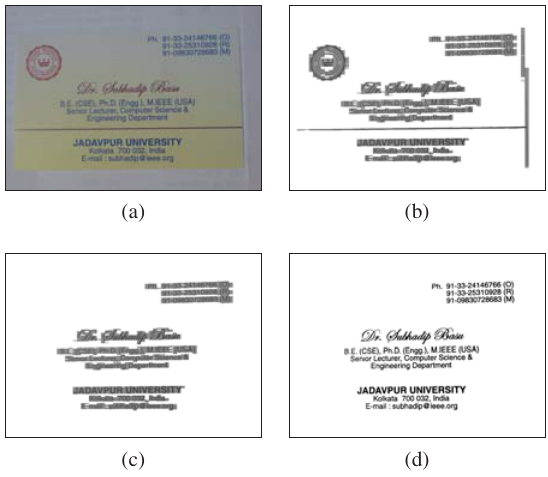
Figure 4. Different stages of text region extraction and binarization. (a) A business card image with non-textual components. (b) Foreground components are isolated (background is suppressed). (c) Non-textual components are identified and removed. (d) Text regions are